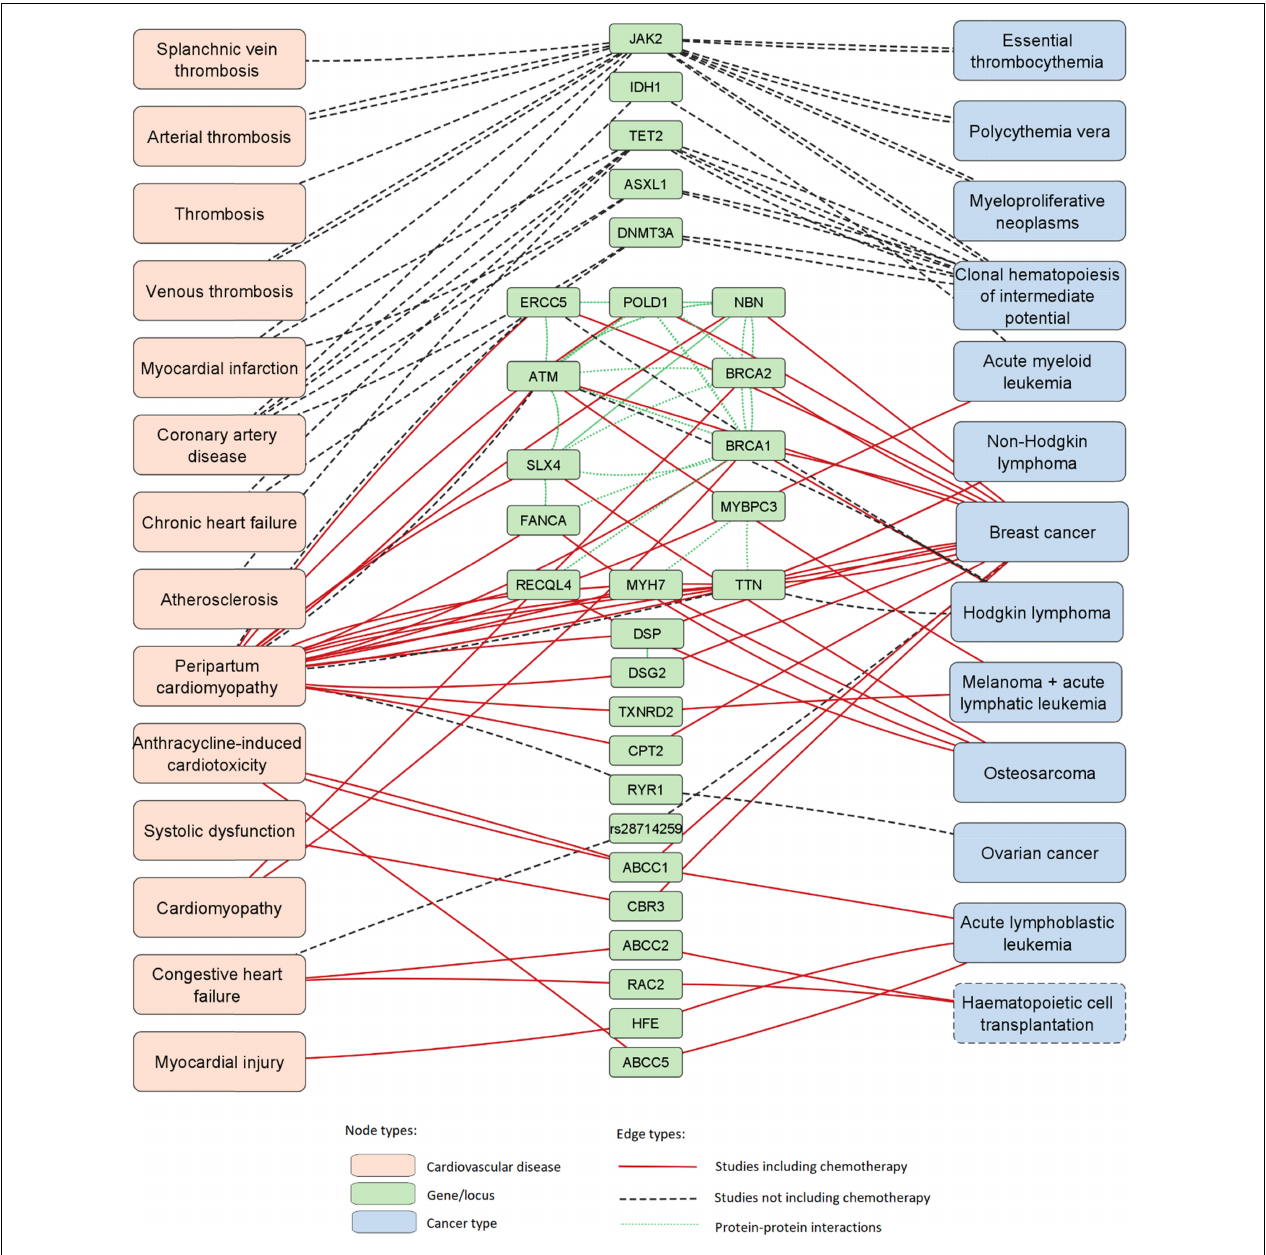
FIGURE 2 | Network of associations between 29 loci (28 genes and 1 SNP), cancer types and CVDs. This network was expanded with data of PPIs. Hematopoietic cell transplantation is marked with a dashed node outline as it is not a